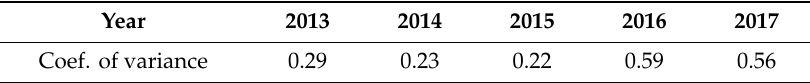
Table 4. Values of coe ffi cient of variance in period